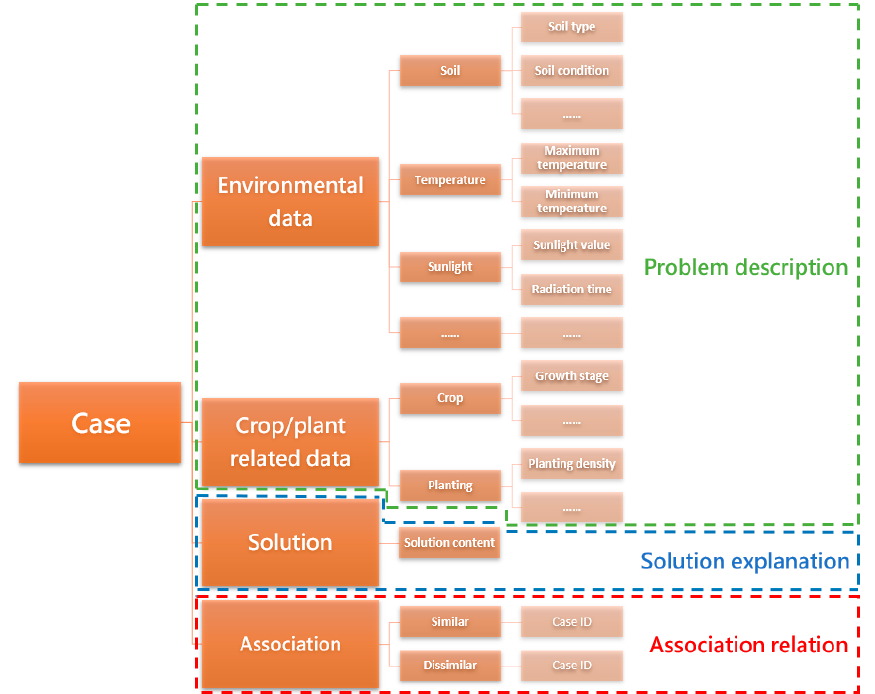
Figure 7. The structure of the associated case representation.